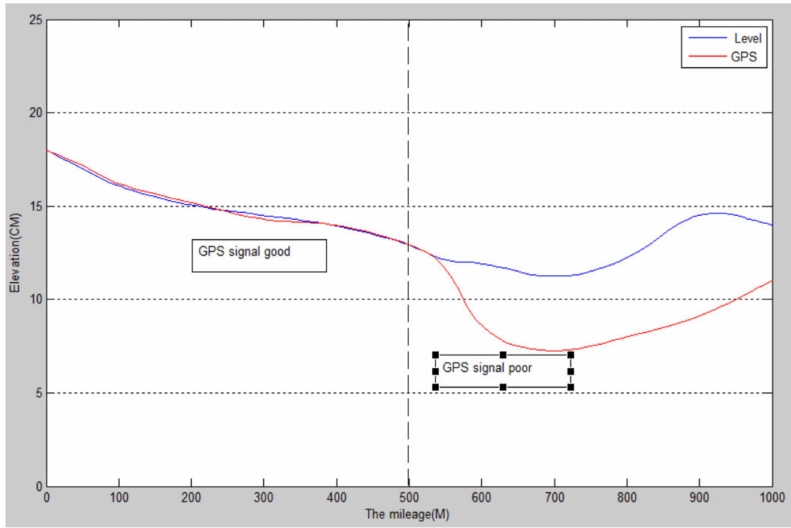
Figure 6. Comparison of measured data of road undulation